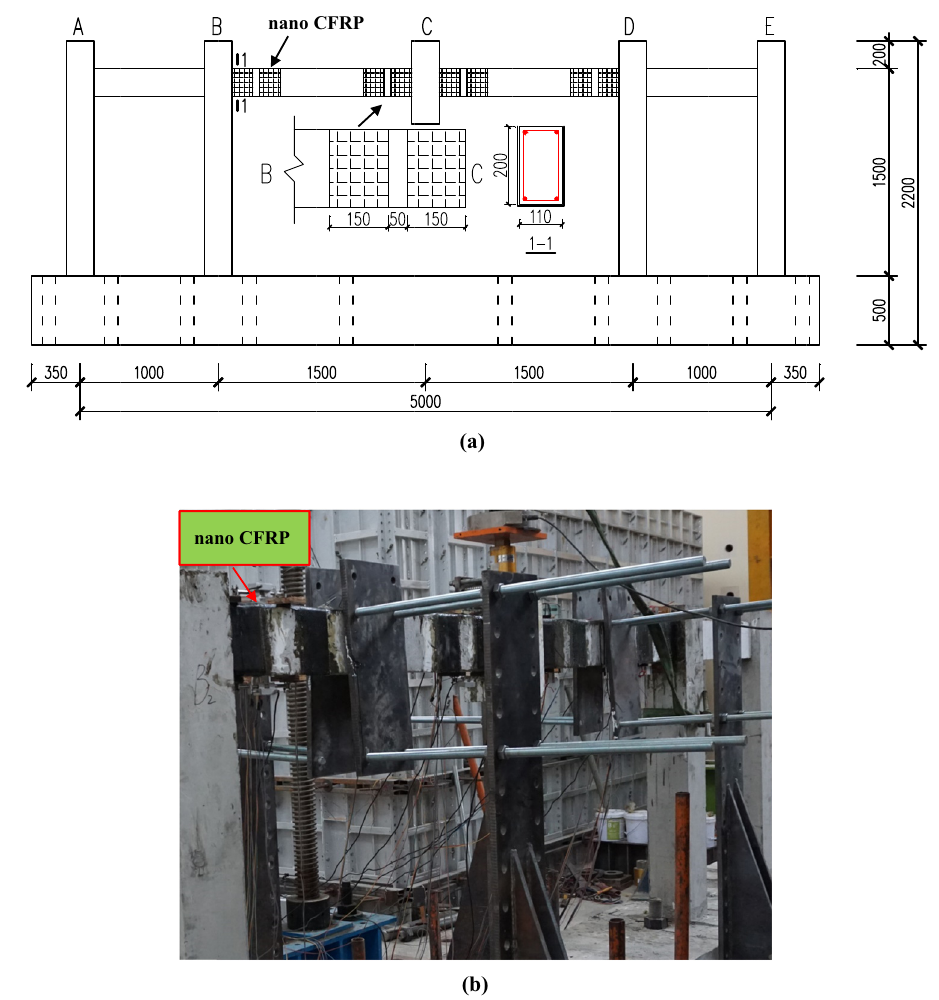
Figure 3: The S2 model with nano CFRP: ( a ) schematic diagram and ( b )